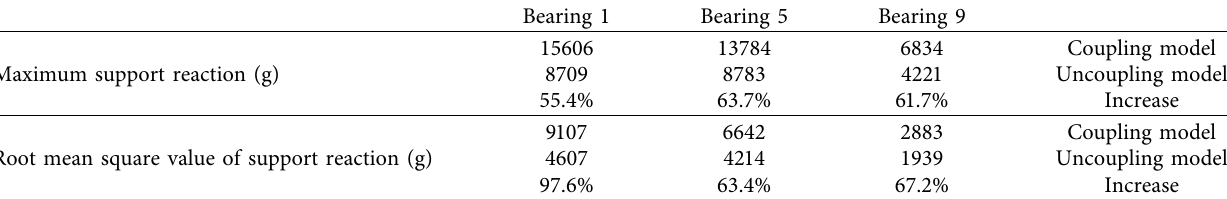
Table 7: Comparison of bearing support